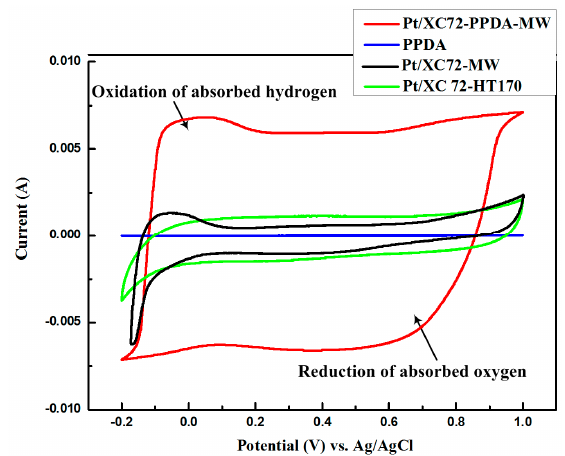
Figure 7. The current-voltammogram curves of PPDA, Pt/XC72-MW, Pt/XC72-HT170, and Pt/XC72-PPDA-MW.